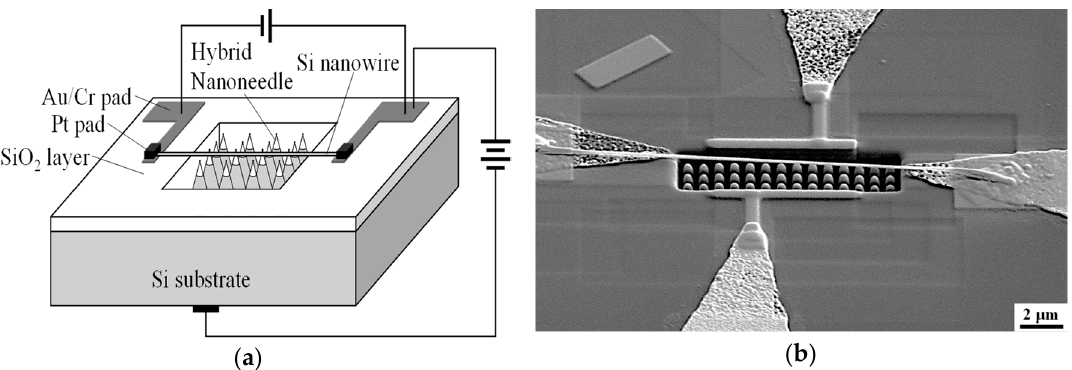
Figure 1. The structure of the ionization gas detection device consisting of a hybrid nanoneedles array and a single Si nanowire: ( a ) a schematic diagram and ( b ) a secondary electron image viewed at an oblique angle of 52°.